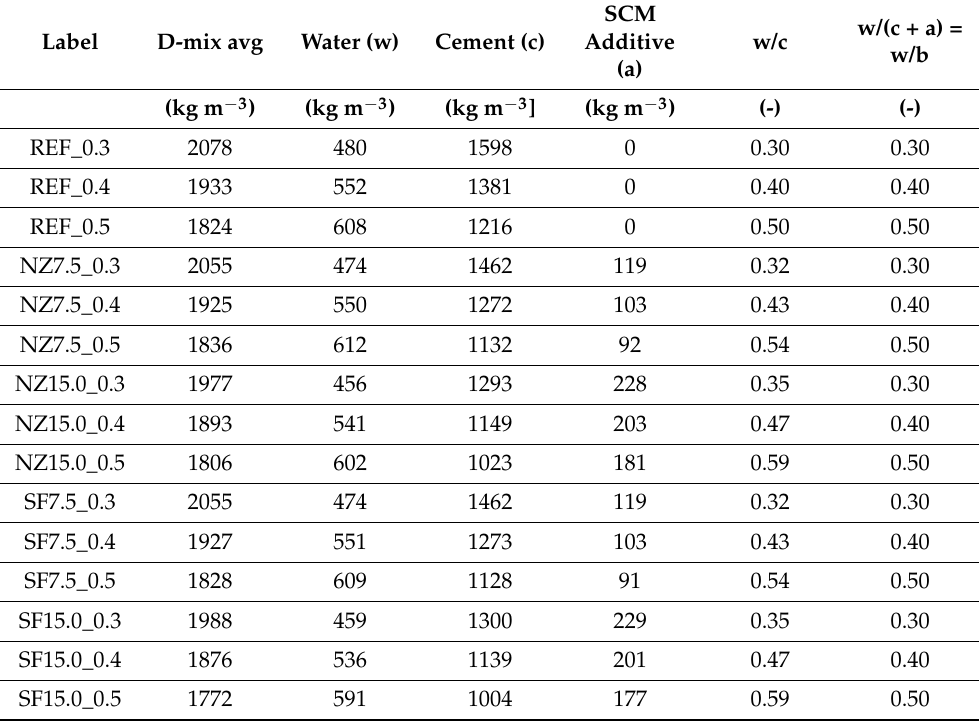
Table 4. Recalculated mix